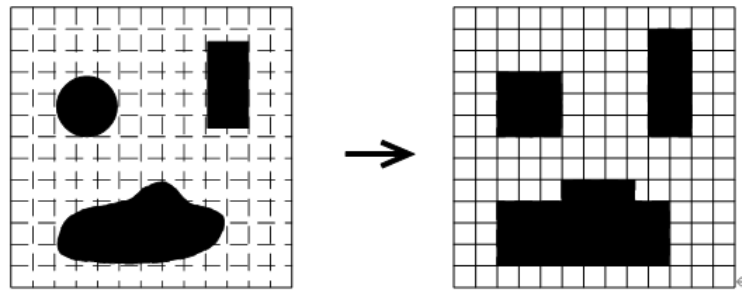
Figure 3. The way to build a grid map.